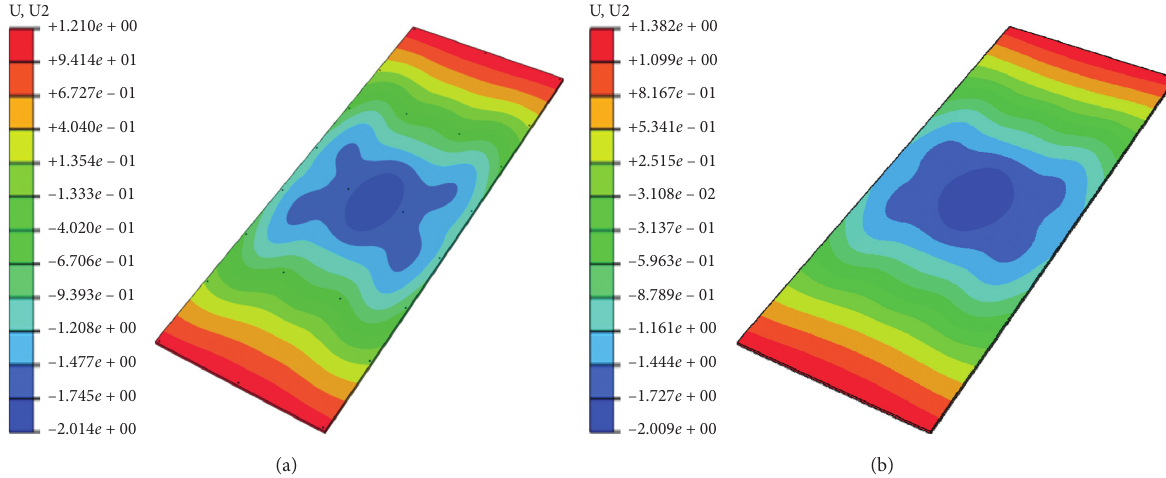
Figure 20: Deflections of the template (unit: mm). (a) Refined model. (b) General model.